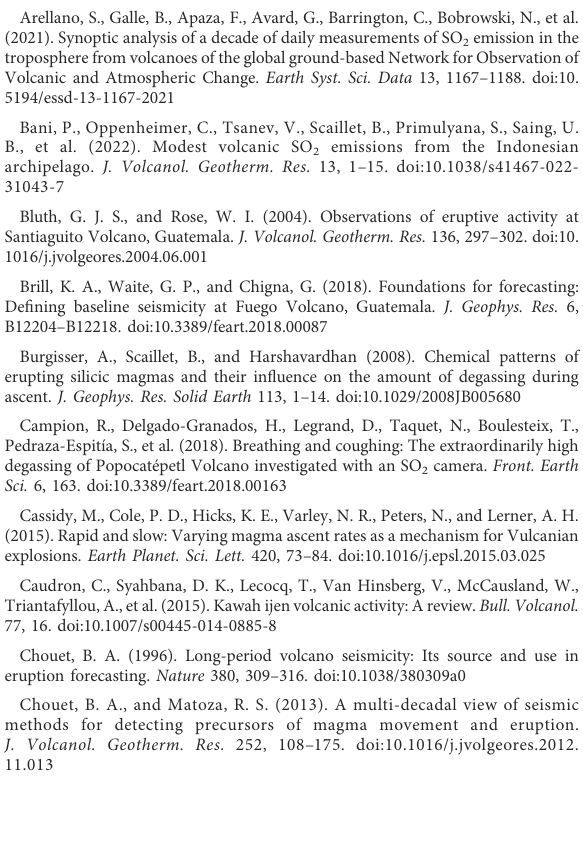
SUPPLEMENTARY TABLE S1 Table of sulfur dioxide emission rates and the number of observed explosions and notable seismic events from Sinabung Volcano, 2016 –